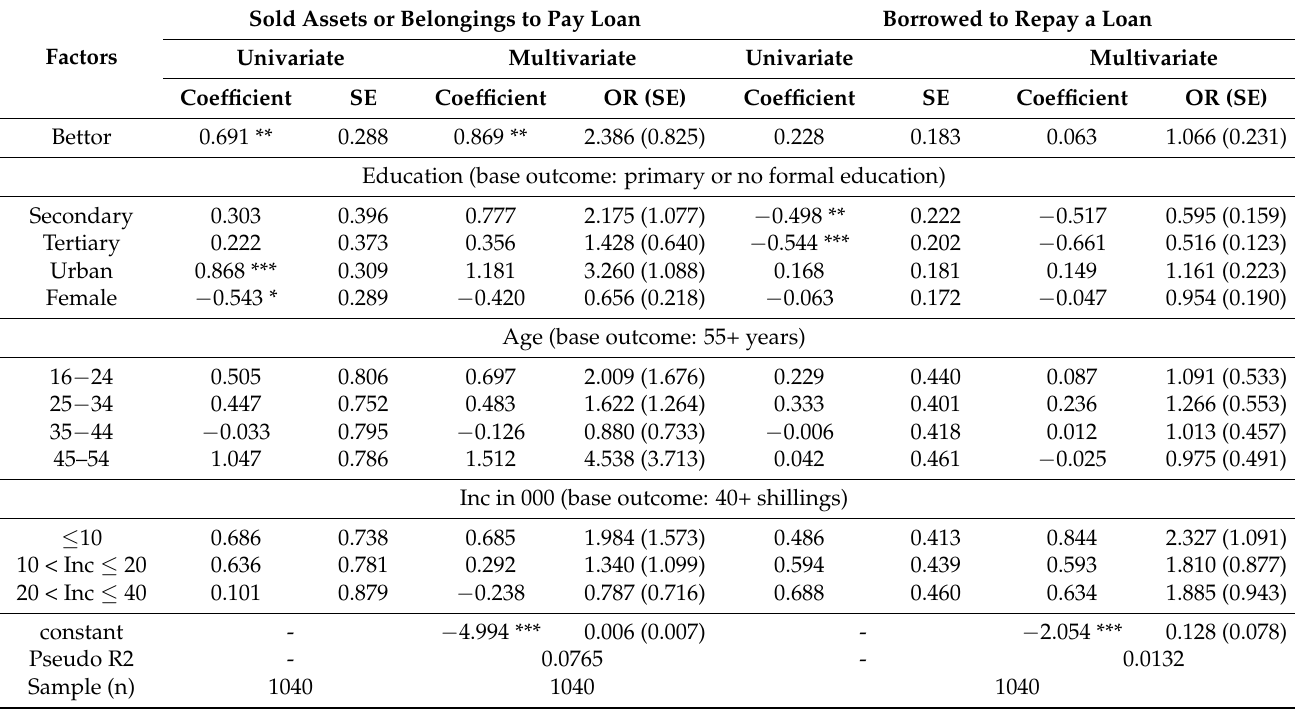
Table 4. Association between betting and coping mechanism.